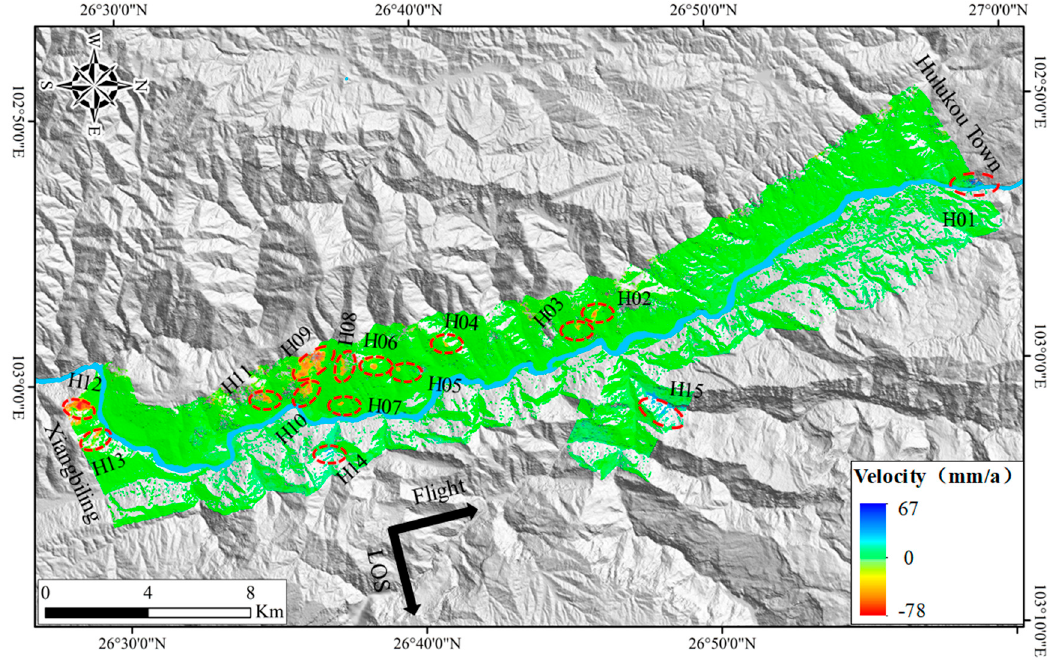
Figure 15. Effective deformation results of Sentinel-1A ascending data in the study area.